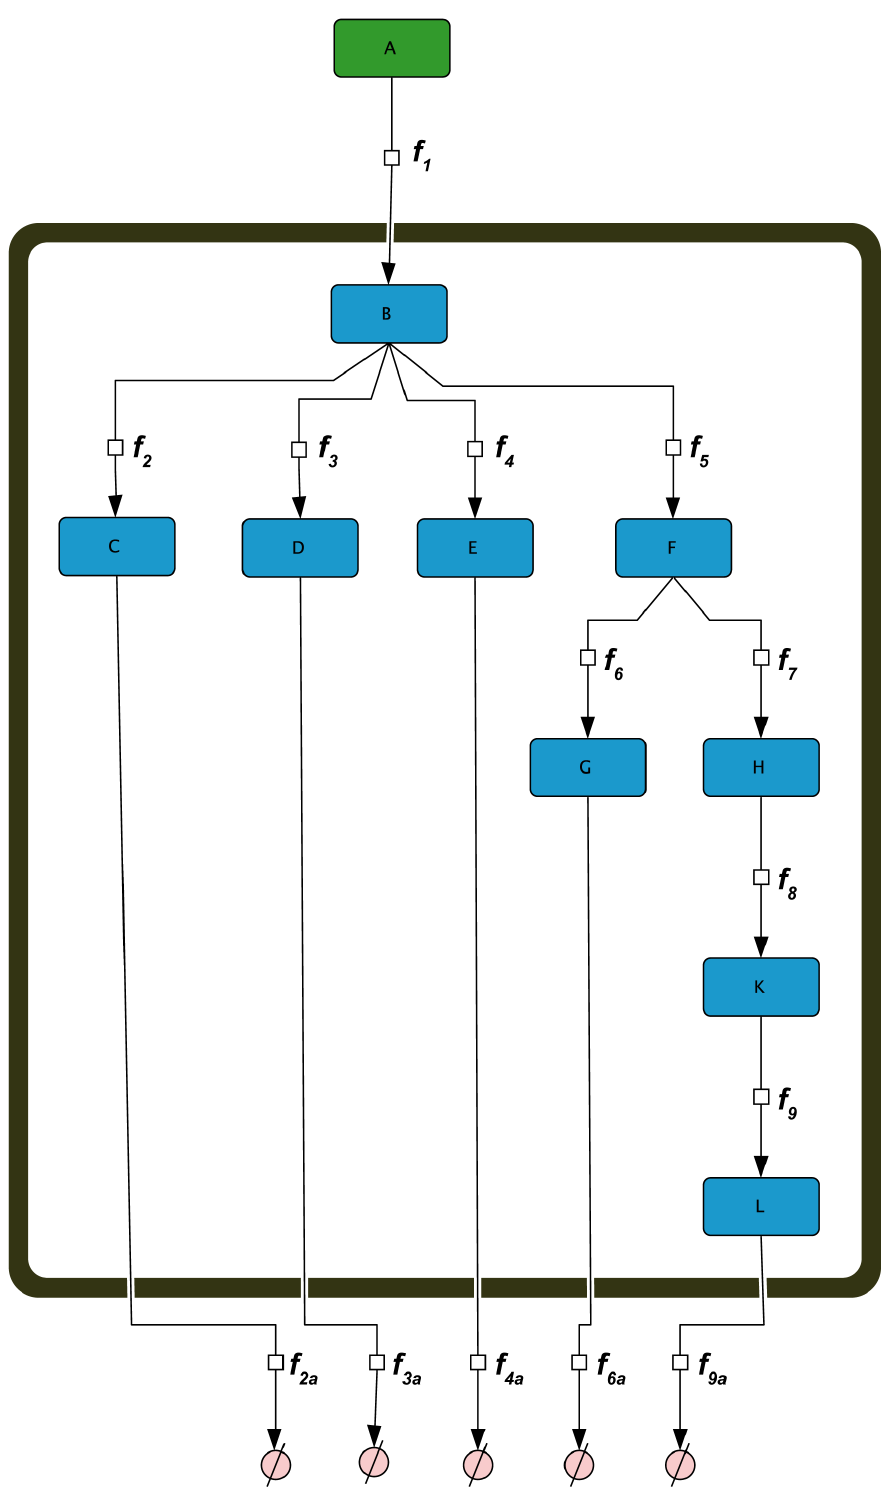
Figure 5. Simplified model structure of the primary metabolism according to metabolic clusters. The model was derived by interconnecting the metabolic clusters by functions of interconversion ( f i ). Clusters are named according to the description in the main text ( Results) and Table S1. doi:10.1371/journal.pone.0092299.g005 diagonal entry of the differential Jacobian for arginine intercon- describes the polyamine biosynthesis. Thus, we provide evidence version was greater than zero which is directly related to f 9 as it that inverse calculation of a differential Jacobian based on